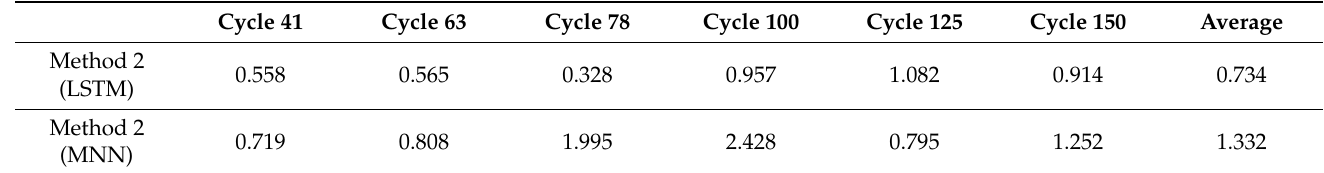
Table 3. SOH estimation error for each model using the NASA battery